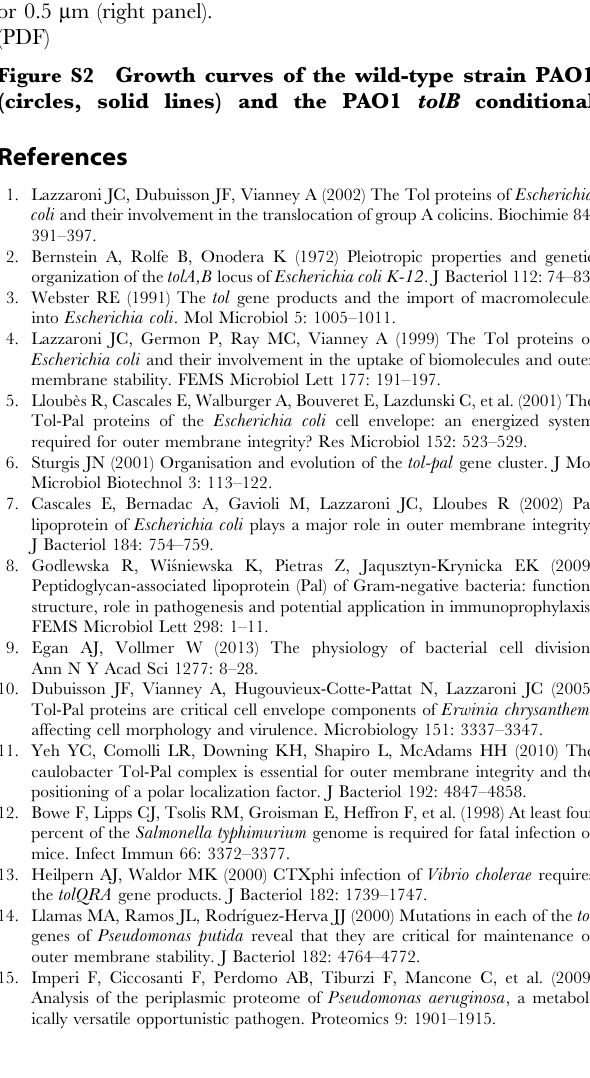
mutant (diamonds, dashed lines) in microtiter plates at 37 6 C in MH broth supplemented with increasing concentrations of sucrose (0–20%). The graph is represen- tative of three independent experiments giving similar results. Figure S3 Viability of PAO1 wild-type cells (WT), TolB- deficient mutant cells ( tolB ) and TolB-proficient mutant cells ( tolB TolB + ) after 3-h incubation in saline solution at 37 6 C, expressed as percent survival with respect to the number of viable cells at time 0. Results are the mean ( 6 SD) of four independent experiments. No significant differences were detected (one-way ANOVA). Table S1 Primers used in this